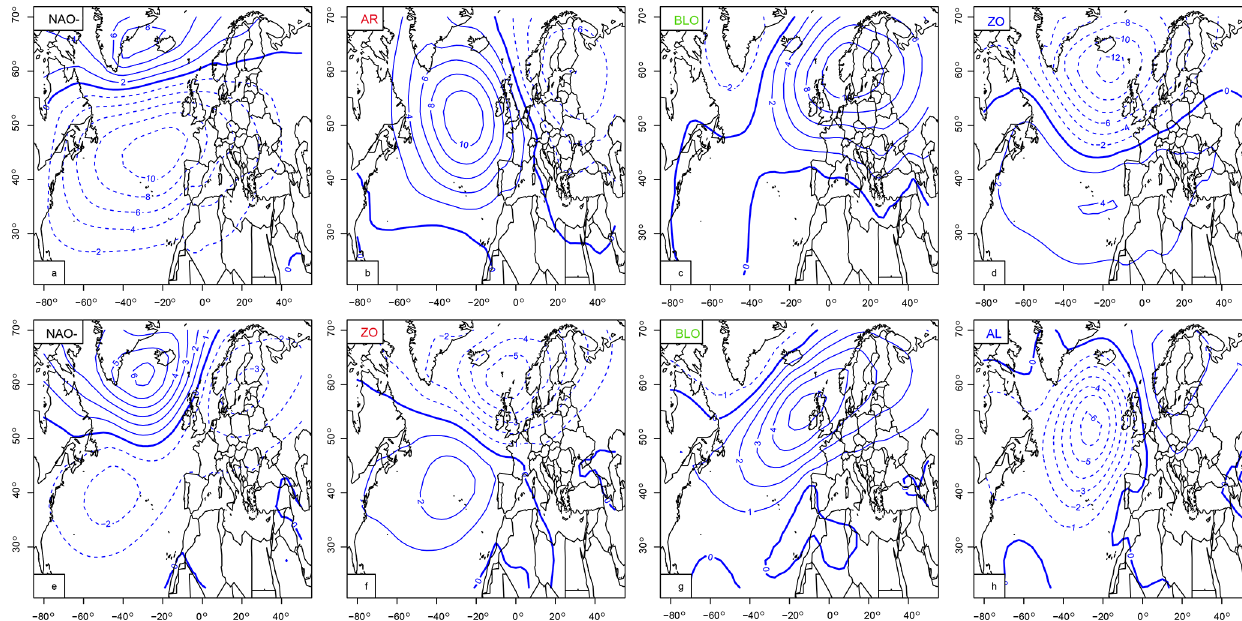
Figure 2. Weather regimes over Europe from SLP fields. Upper panels (a) – (d) contain winter (December–January–February: DJF) regimes: negative phase of the North Atlantic oscillation (NAO − ), Atlantic Ridge (AR), Scandinavian blocking (BLO), and Zonal regime (ZO). Lower panels (e) – (h) contain summer (June–July–August: JJA) weather regimes: negative phase of the North Atlantic oscillation (NAO − ), Zonal (ZO), Scandinavian blocking (BLO) and Atlantic low (AL). The isolines show seasonal anomalies with respect to a DJF and JJA, inhPa with 2hPa